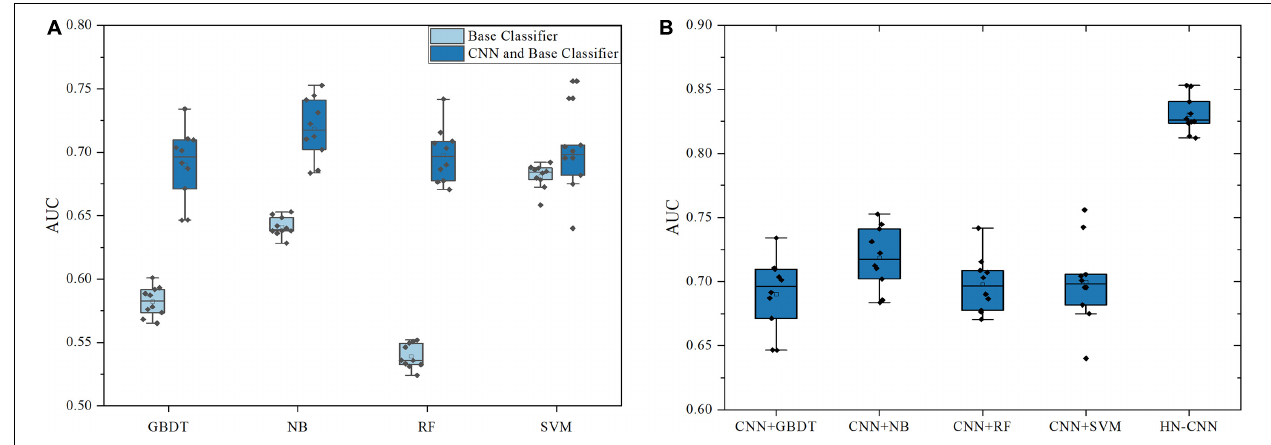
FIGURE 3 | The AUCs of HN-CNN and other methods. (A) The AUCs of base classifiers with/without CNN. (B) The AUCs of HN-CNN and base classifiers with CNN. TABLE 1 | Case